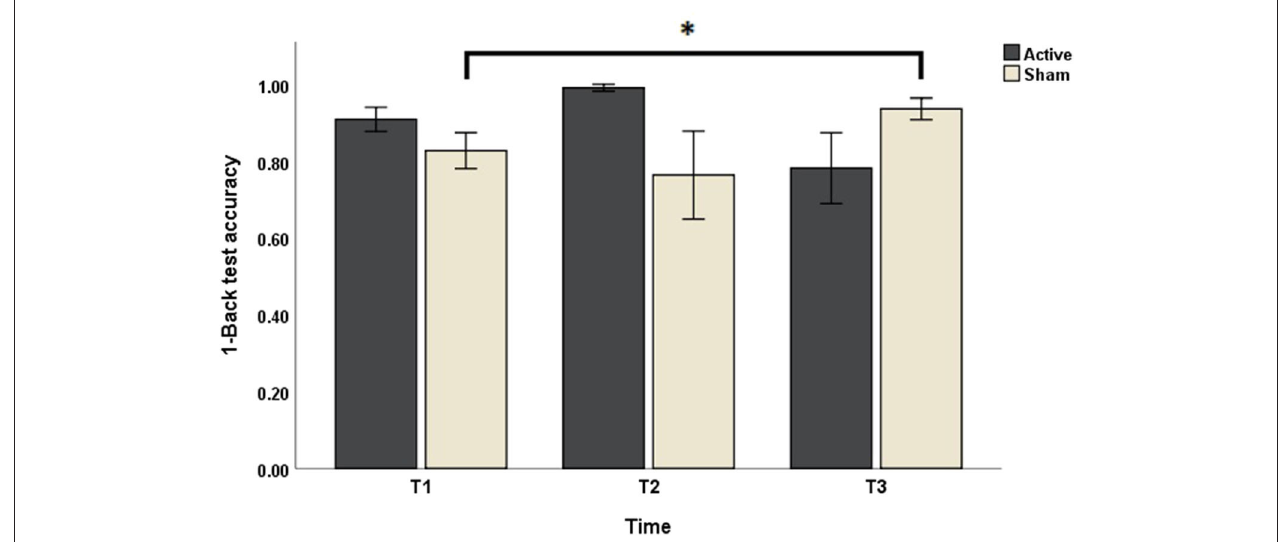
FIGURE 2 | The effects of sham and active stimulation on 1-Back test accuracy. T1, T2, and T3: day 1, day 5, and 1 week after each stimulation block, respectively. * p <